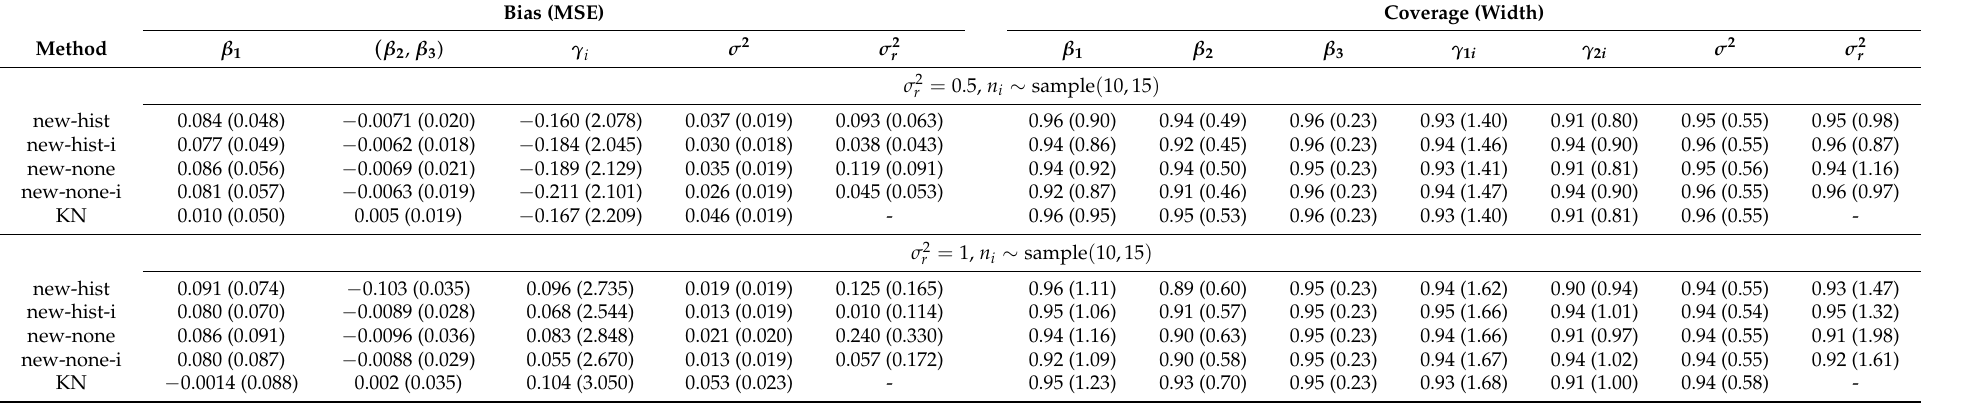
(cid:17) (cid:16) ( Z (cid:48) Z i ) − 1 0 , g n i ; KN refers to the prior introduced in w i i